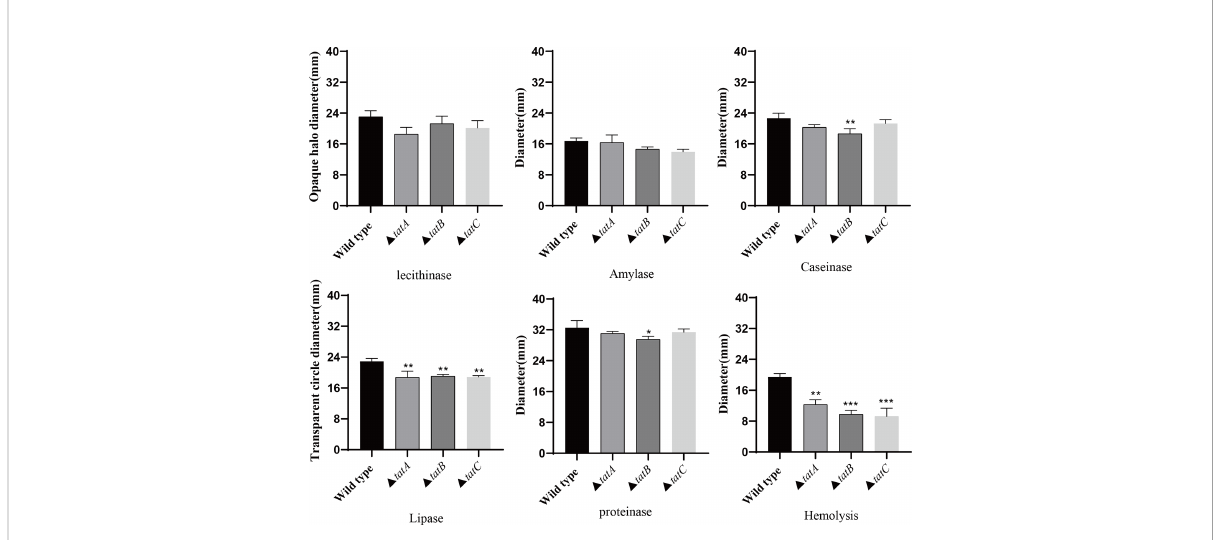
FIGURE 11 The extracellular enzyme activity characteristics of wild type, D tatA , D tatB , and D tatC mutants. Data are presented as mean ± SD. Three independent biological replicates were performed for each group. * P < 0.05, ** P < 0.01, *** P <